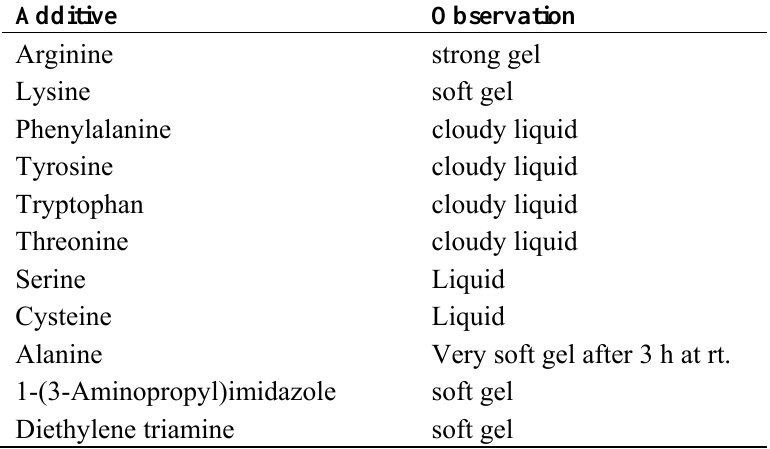
Table 3. Reaction of selected amino acids and amines with HM pectin and papain, taken from